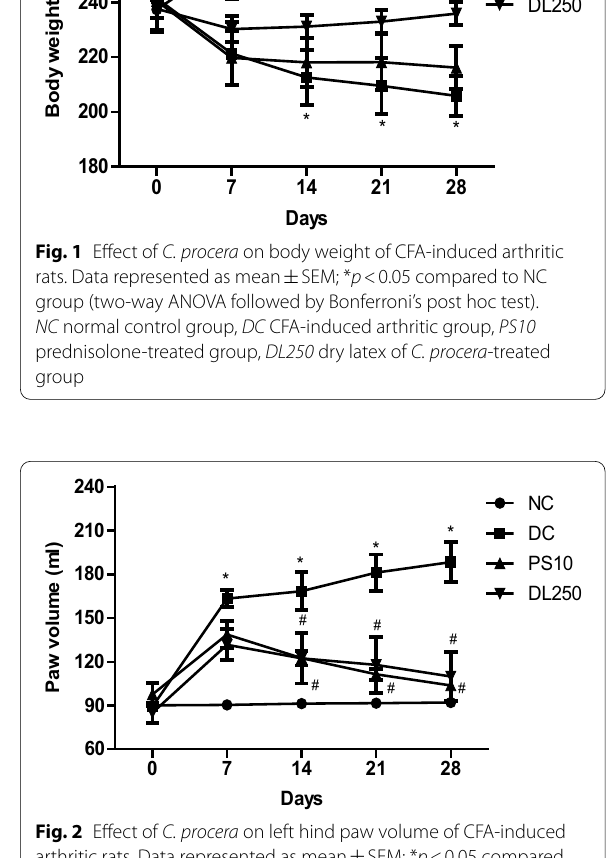
Fig. 2 Effect of C. procera on left hind paw volume of CFA-induced arthritic rats. Data represented as mean SEM; * p < 0.05 compared ± to NC group; # p < 0.05 compared to DC group (two-way ANOVA followed by Bonferroni’s post hoc test). NC normal control group, DC CFA-induced arthritic group, PS10 prednisolone-treated group, DL250 dry latex of C. procera -treated